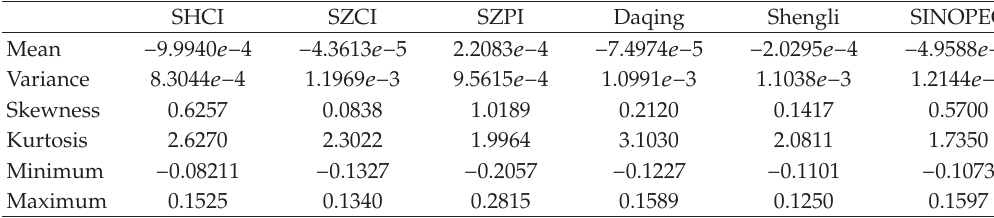
Table 5: Returns statistics of the predictive data.